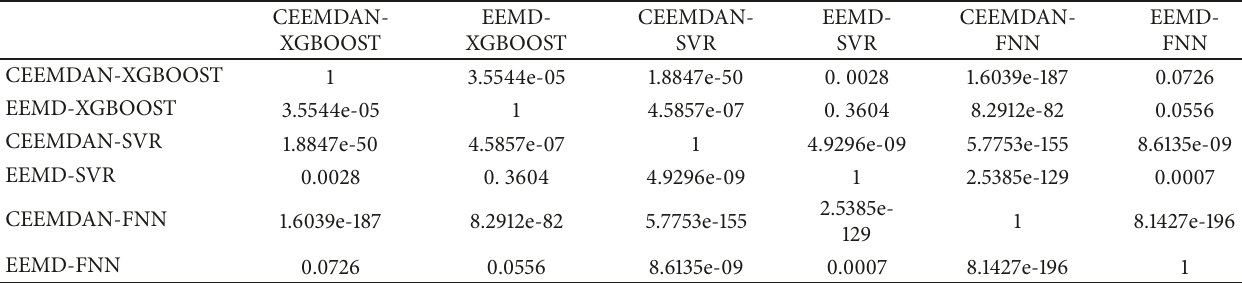
Table 6: Wilcoxon signed rank test between XGBOOST, SVR, and FNN with EEMD or CEEMDAN.